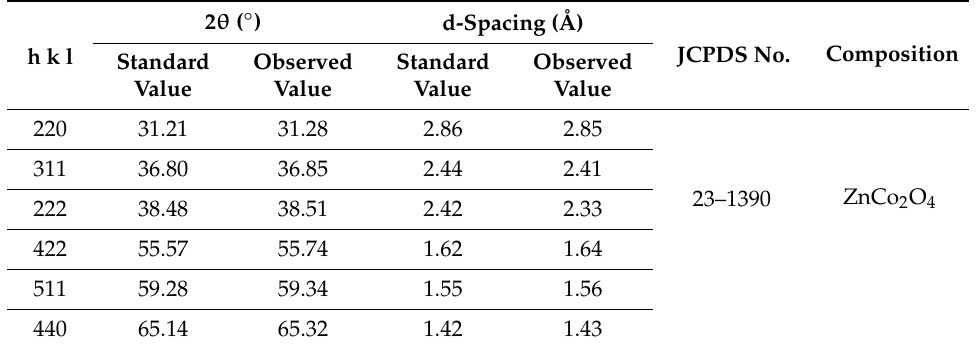
Table 1. XRD data for the ZnCo 2 O 4 microstructures.